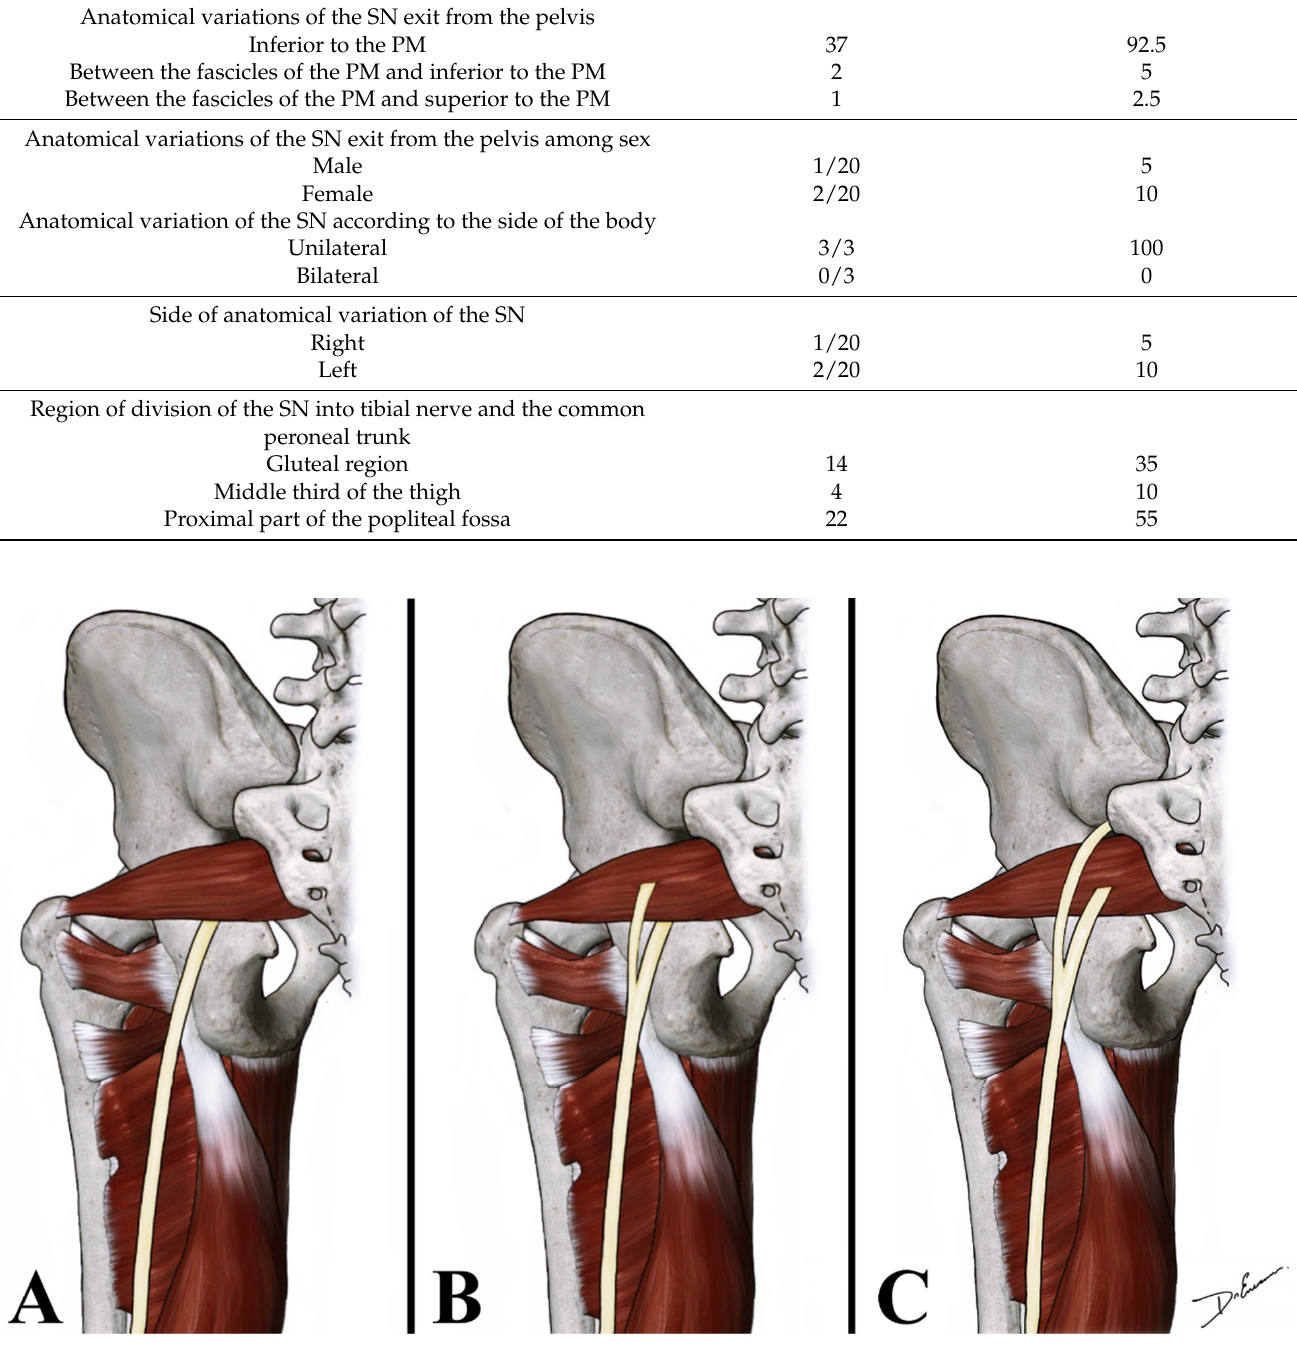
Figure 1. Anatomical drawing shows the relationship of the SN with the PM. SN can exit from the pelvis inferior to the PM ( A ); between the fascicles of the PM and inferior to the PM ( B ); and between the fascicles of the PM and superior to the PM ( C ).